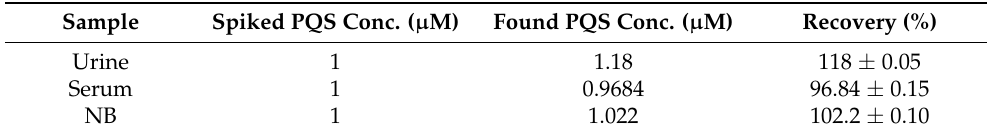
Table 4. Real sample analysis spiked with 1 µ M PQS.